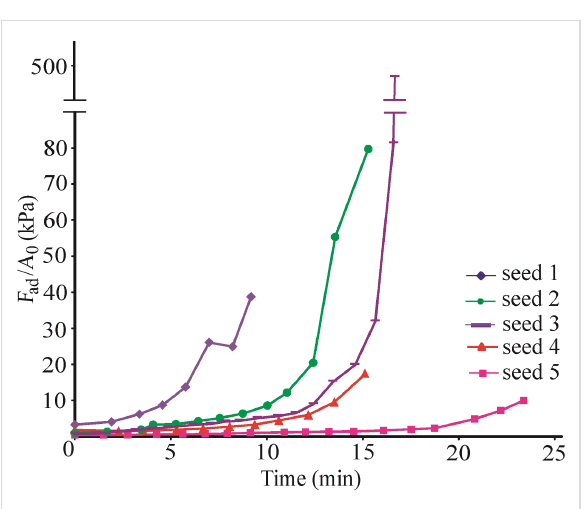
Figure 4: The ratio of pull-off force ( F ad ) to contact area ( A 0 ) (adhe- sion stress) for five individual seeds as a function of time. The smallest adhesion stress was observed for the seed demonstrated the highest contact area and pull-off force.